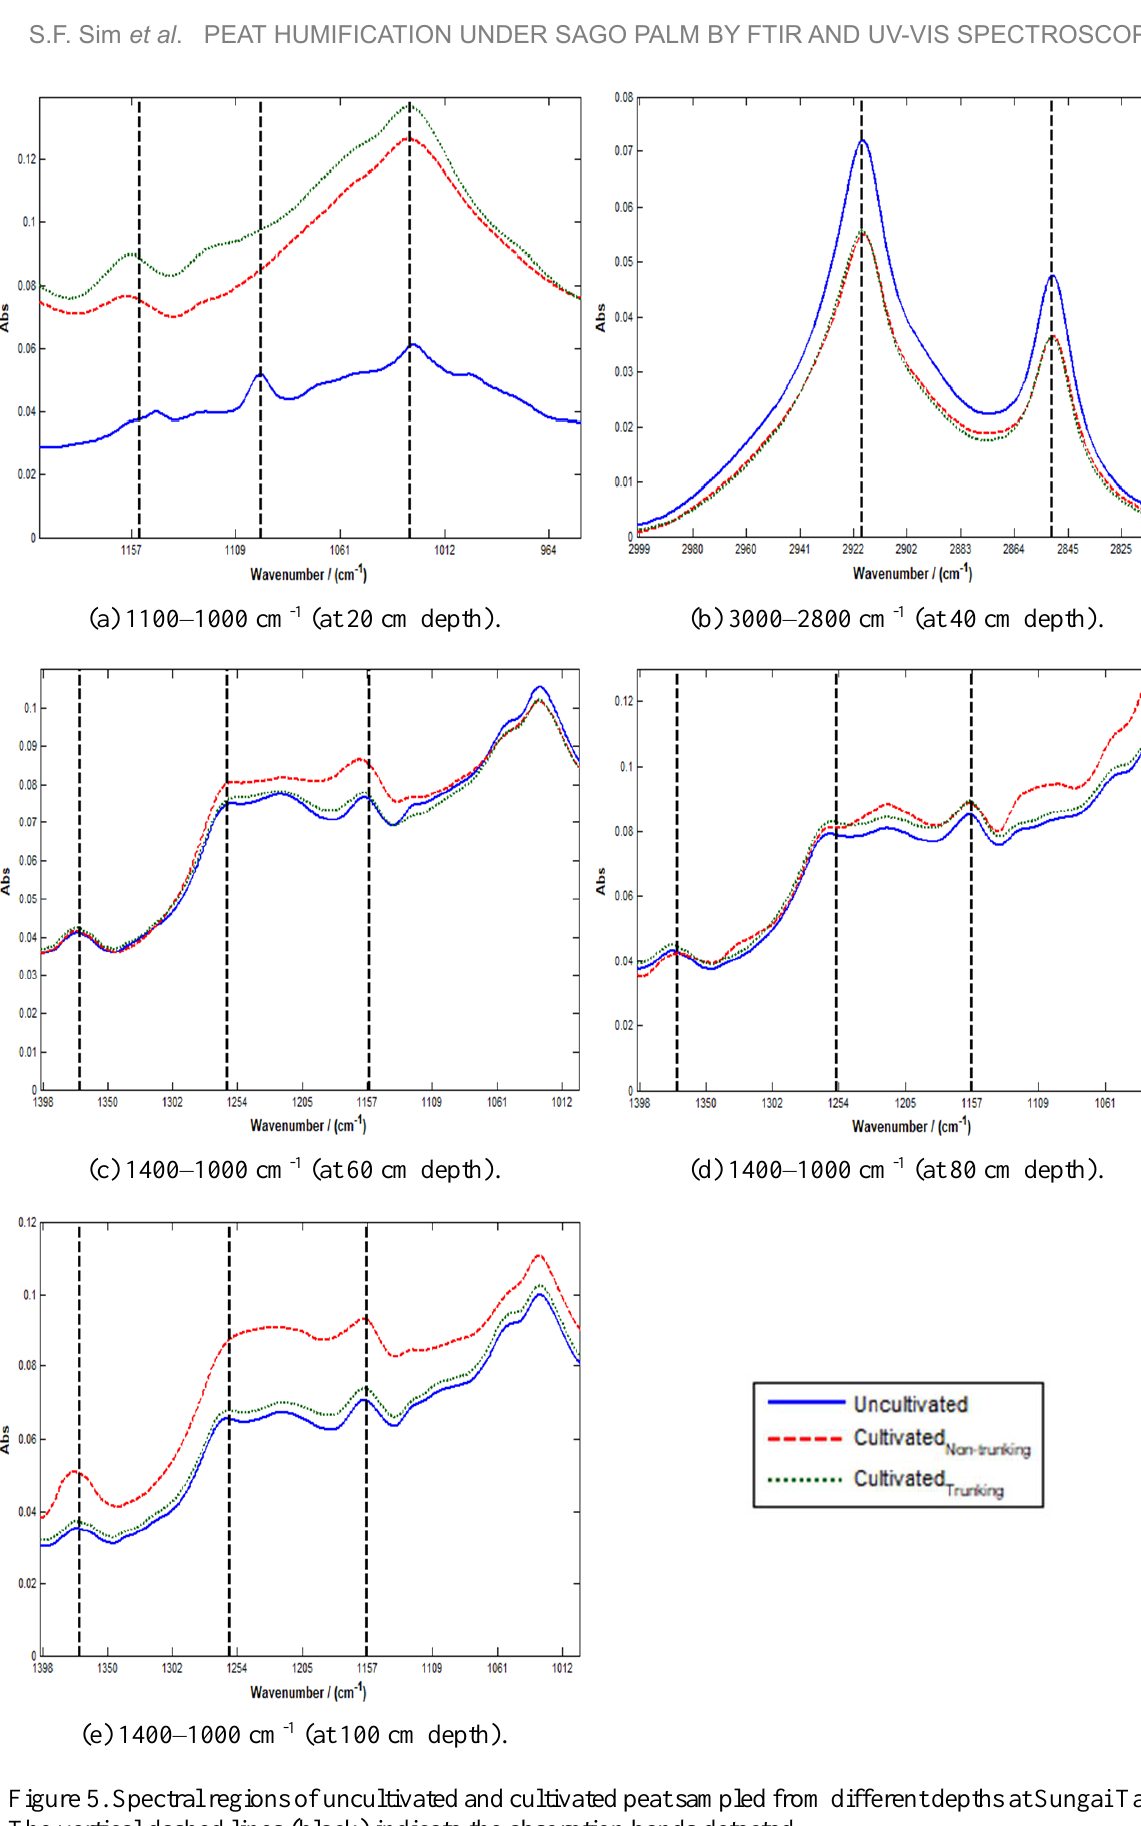
Figure 5. Spectral regions of uncultivated and cultivated peat sampled from different depths at Sungai Talau. The vertical dashed lines (black) indicate the absorption bands